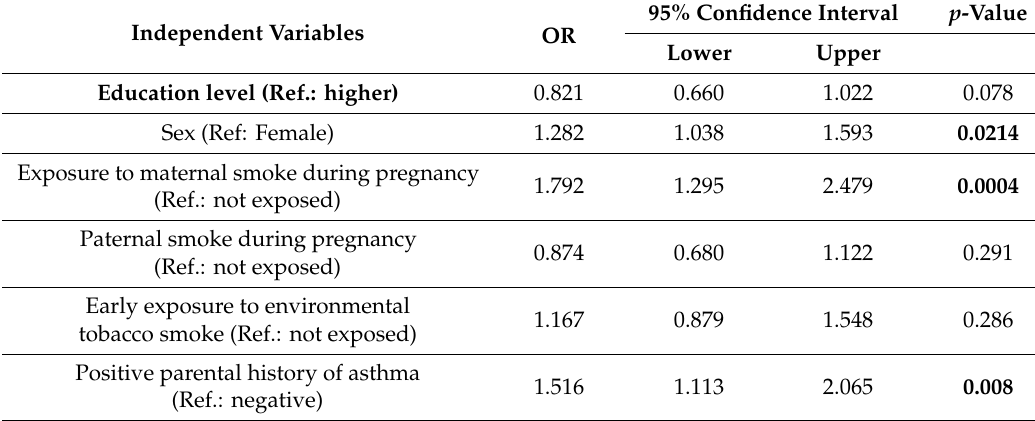
Table 2. Multiple logistic association model for acute respiratory diseases in the first two years in the overall study population ( n = 1714). OR: Odds Ratio. Significant p values are in